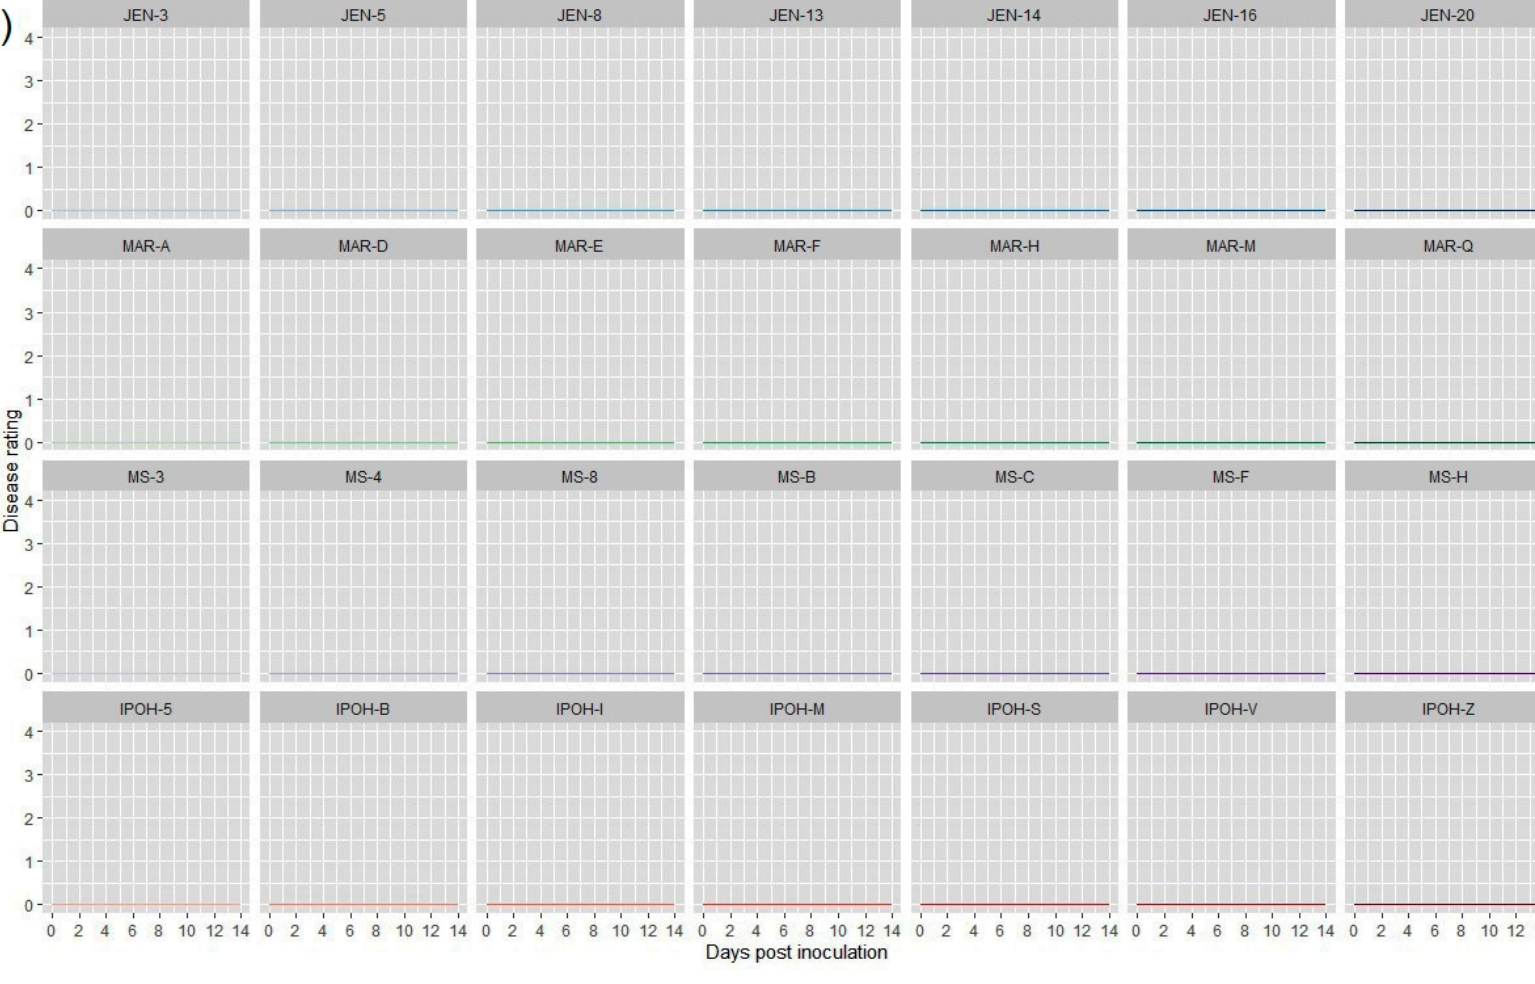
Figure 6. The median disease rating progression (0–4) of Pantoea stewartii subspecies stewartii ( n = 28) inoculated on jackfruit varieties ( a ) Tekam Yellow J33; ( b ) Hong 34; and ( c ) Subang Chap Boy J39, within 14 days post-inoculation. The color ranges and columns displayed are based on collection areas: blue on the Jenderam isolates (column 1); green on the Maran isolates (column 2); purple on the Muadzam Shah isolates (column 3); and red on the Ipoh isolates (column 4).